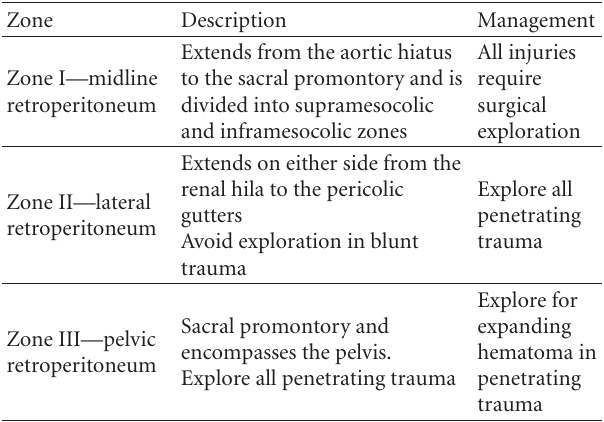
Figure 5: IAP and creatinine profiles (Case 2). Table 1: Diagnostic classification of retroperitoneal